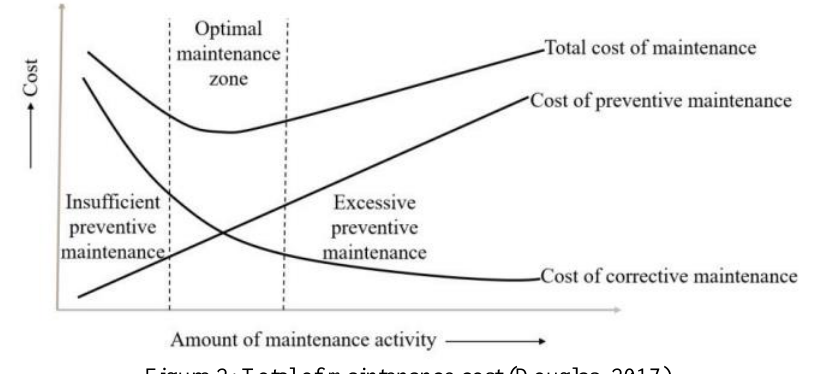
Figure 2: Total of maintenance cost (Douglas, 2017)